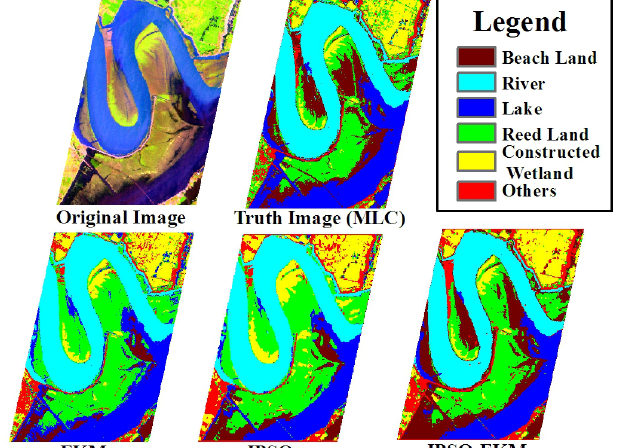
Figure. 6 The classification results of the three